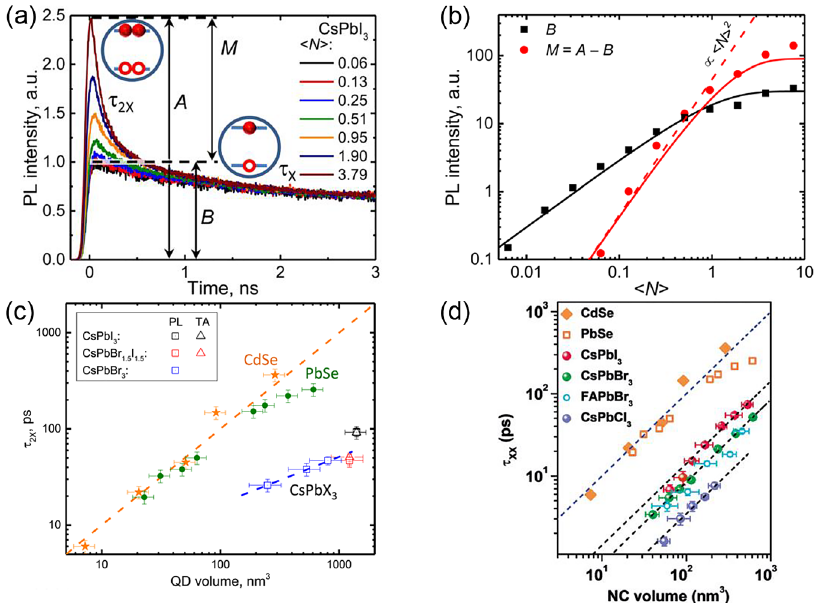
Figure 5: (a) Pump-fluence-dependent PL dynamics of CsPbI 3 nanocrystals. Sym- bols A and B denote the amplitudes of the total PL signal and the single-exciton component, while M = A − B denotes the amplitude of the multiexciton signal. (b) Pump- fl uence-dependence of the amplitudes of single-exciton (B, black squares) and multiexciton emission components ( M = A − B , red circles). (c) Biexciton Auger lifetimes in